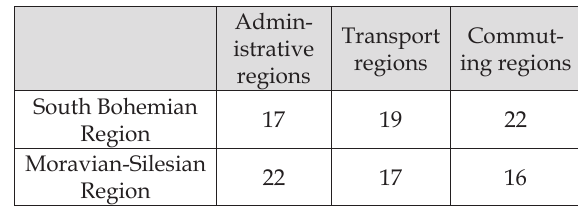
Table 2. Number of delimited regions in the